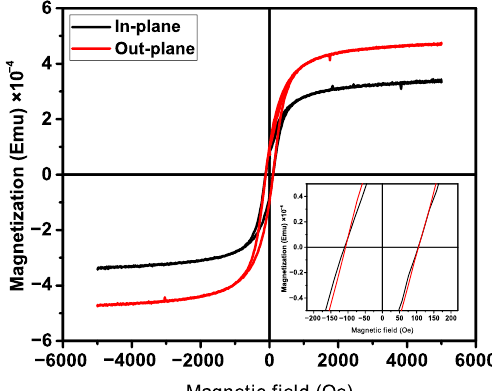
Figure 5. Room temperature M-H loops for PVDF/BFO, measured under in-plane and out-plane conditions at